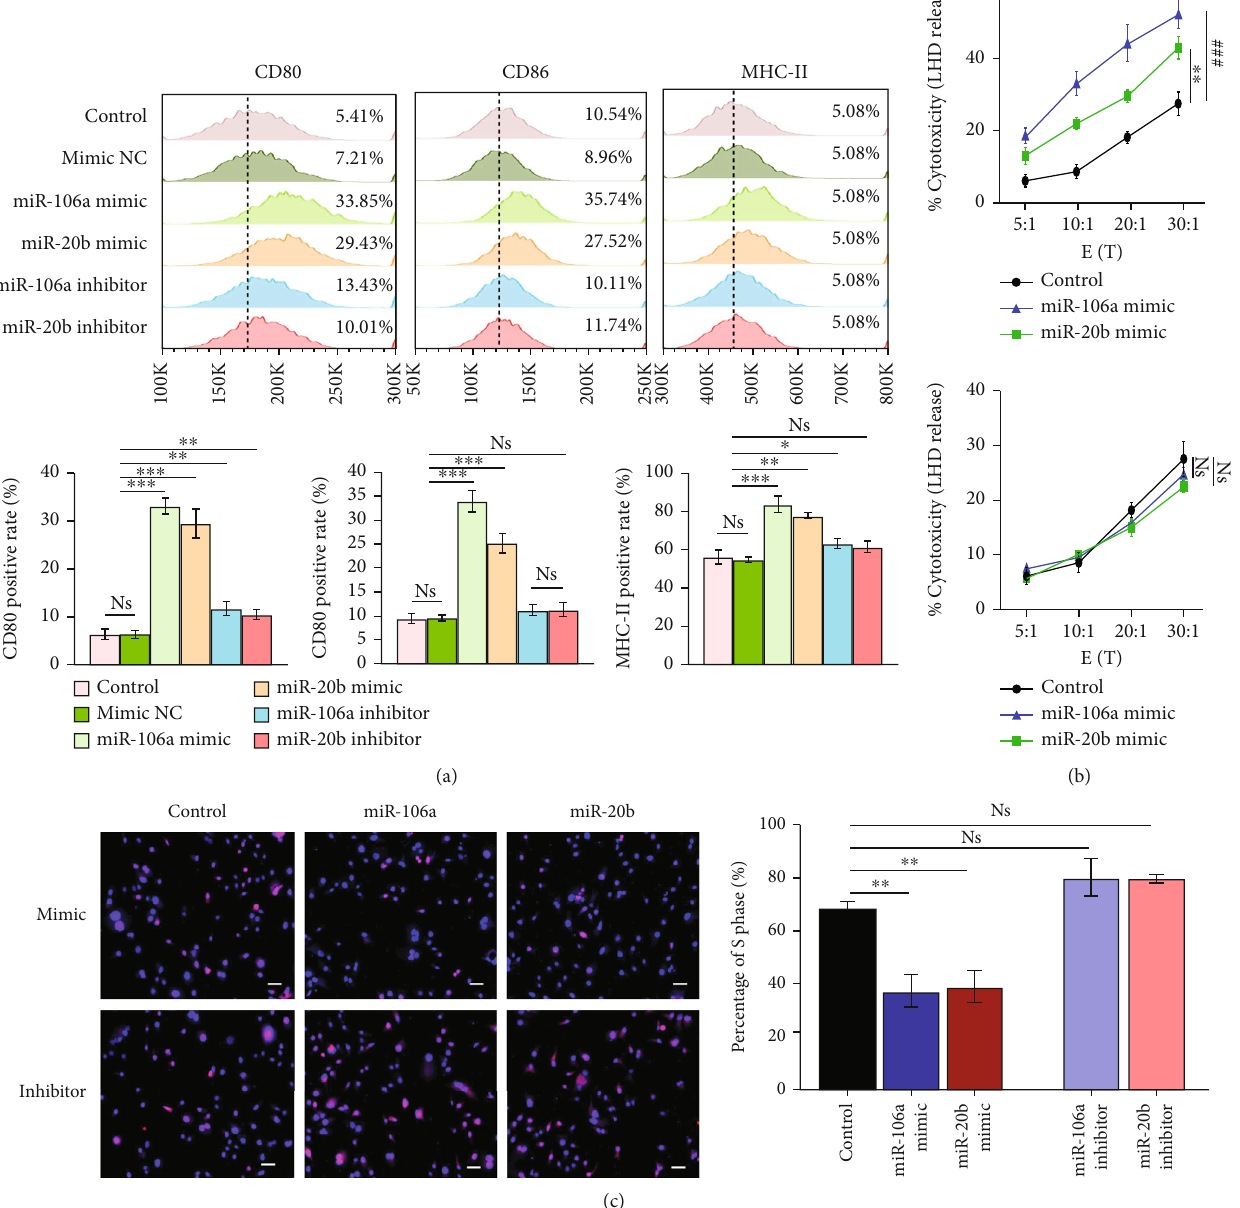
Figure 8: The e ff ect of miR-106a/20b levels on the maturation of DCs and the cytotoxicity of induced T-lymphocytes against GSCs in each group. (a) The expressions of CD80, CD86, and MHC-II in the miR-106a/20b mimic group was distinctly higher than that in the control DC group by Flow cytometry analysis. (b) LDH release assay was applied for the detection of the cytotoxicity of T cells in the miR-106a/20b mimic group; substantially higher cytotoxicity against GSCs relative to the control group at di ff erent E/T ratios was observed. (c) GSC proliferation was determined by EdU staining. ∗∗ p < 0 : 01